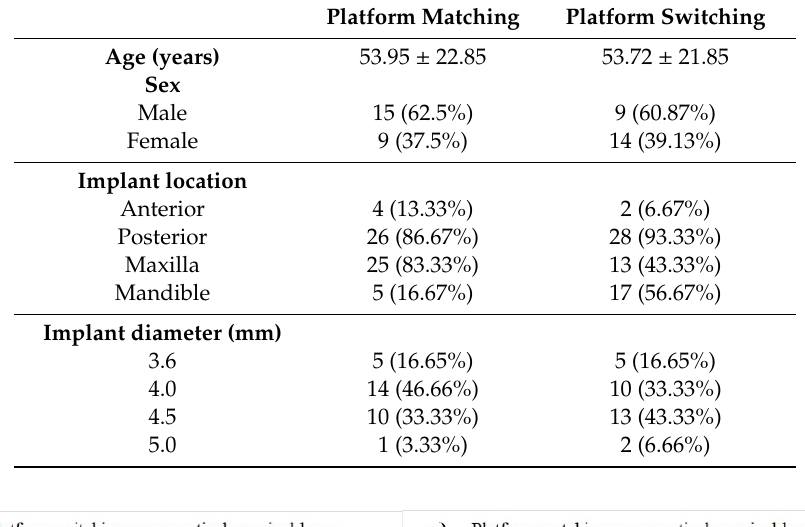
Table 1. Demographic Information.